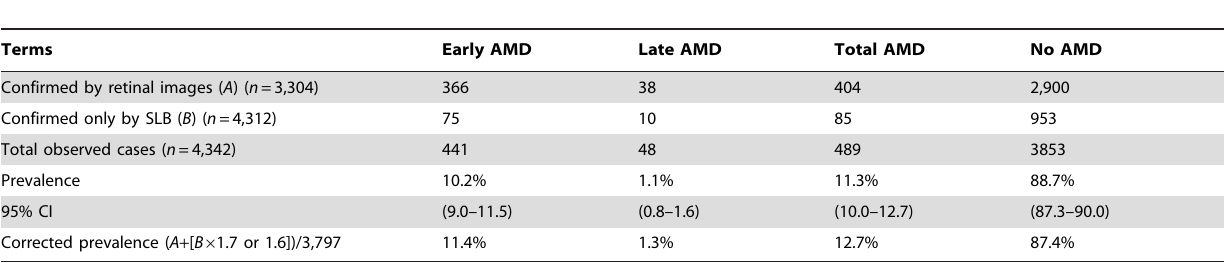
Table 5. Determination of all AMD cases and adjusted prevalence including diagnosis by